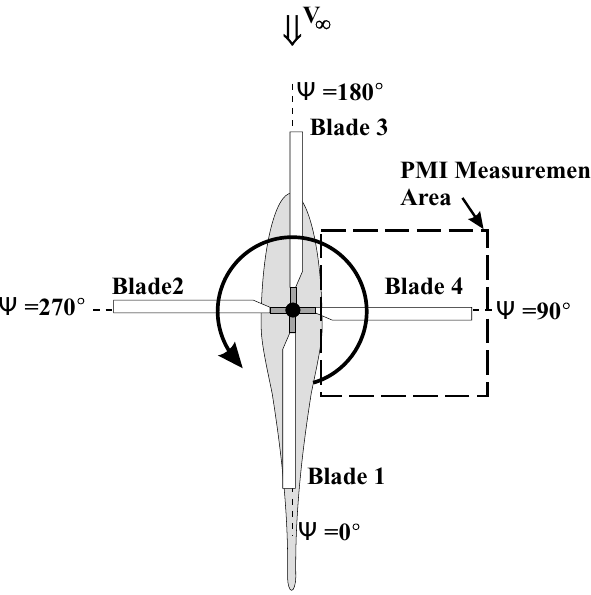
Fig. 7. Rotor azimuth and blade numbering convention. The PMI measurement area is also illustrated.